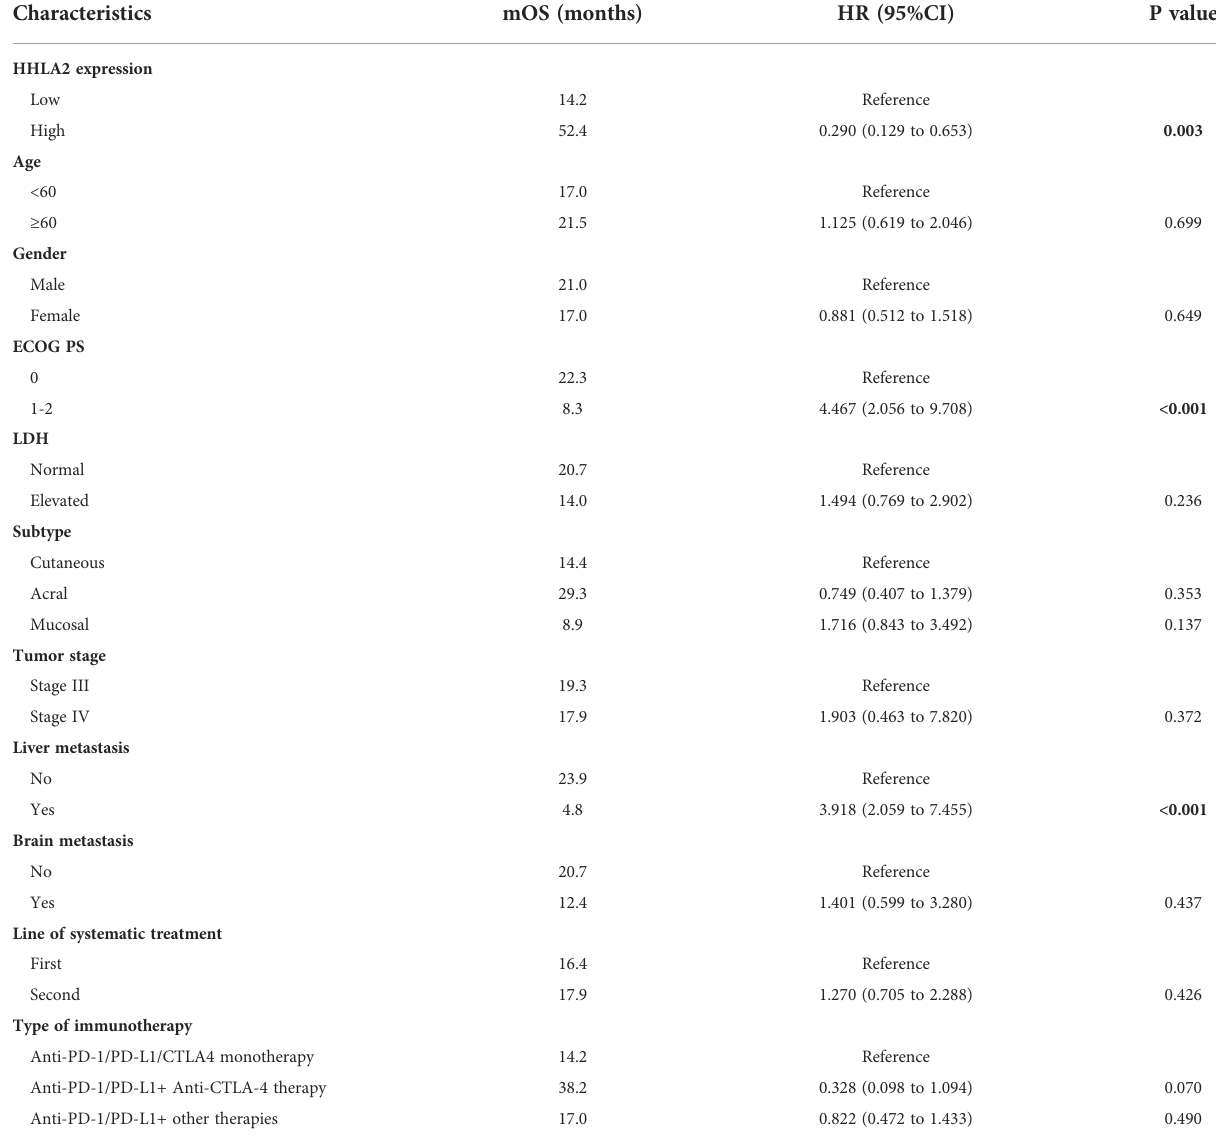
TABLE 3 Univariate analysis of prognostic factors correlated with